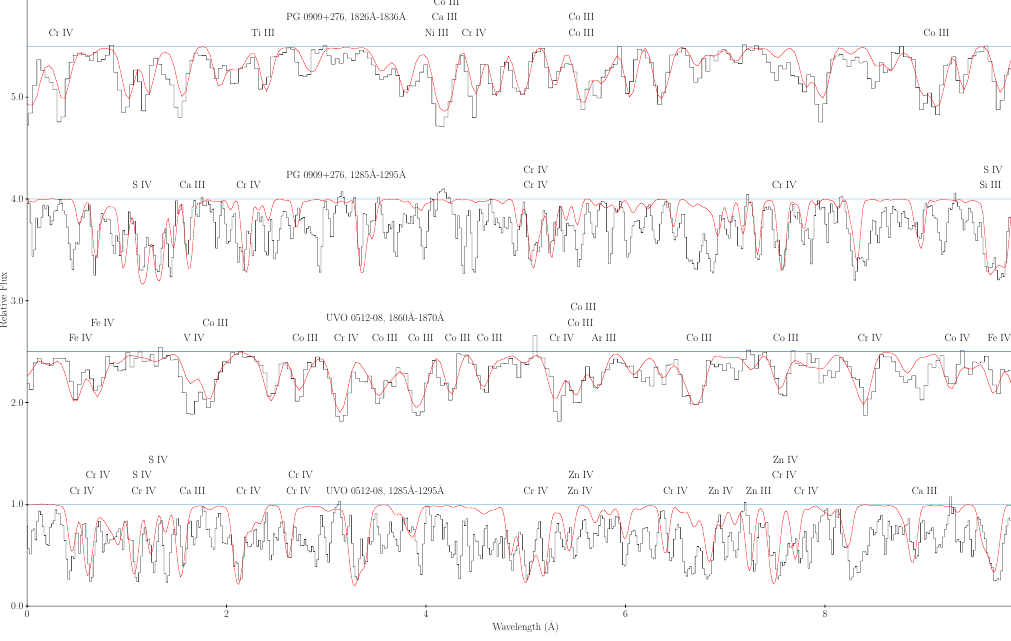
Figure 2. Samples of the normalized FUV and NUV spectra of PG0909+276 and UVO0512–08. For PG0909+276, lines with equivalent widths more than 0.04Å are labelled. For UVO0512–08, lines with equivalent widths more than 0.05Å are labelled. The segments are all plotted to the same scale and offset vertically by 0, 1.5, 3 and 4.5 units respectively. The estimated continuum is marked as an horizontal